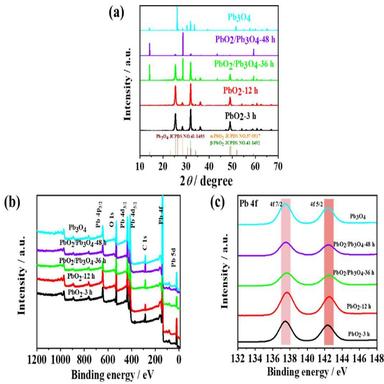
(a) XRD patterns and XPS spectra of (b) Pb 4f, (c) general scan.